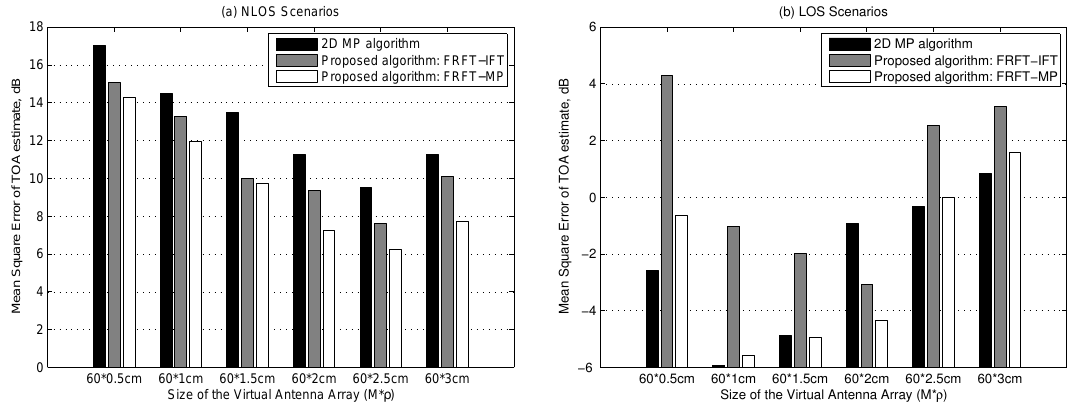
Figure 4. Mean square error versus virtual antenna array size in NLOS scenarios and LOS scenarios,